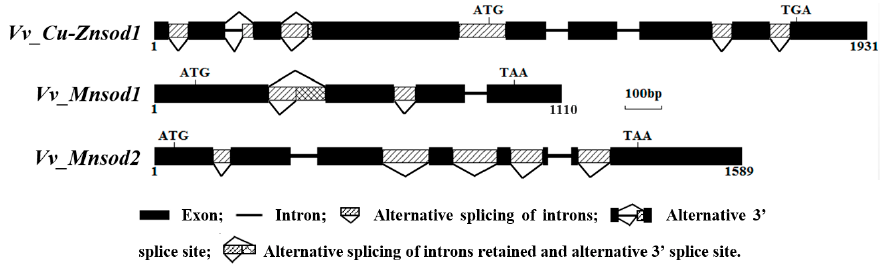
Figure 1. Schematic representation of the V. volvacea sod gene structures.